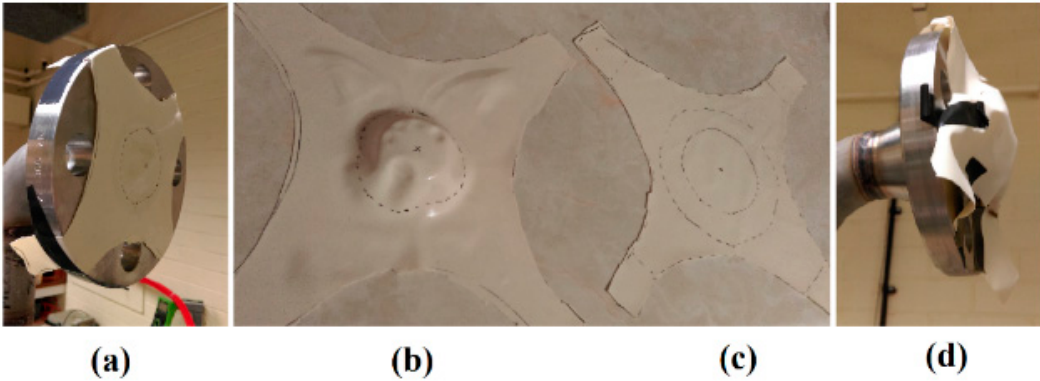
Figure 14. ( a ) A membrane assembled on a flange; ( b ) concave membrane; ( c ) flat membrane; ( d ) loose membrane.